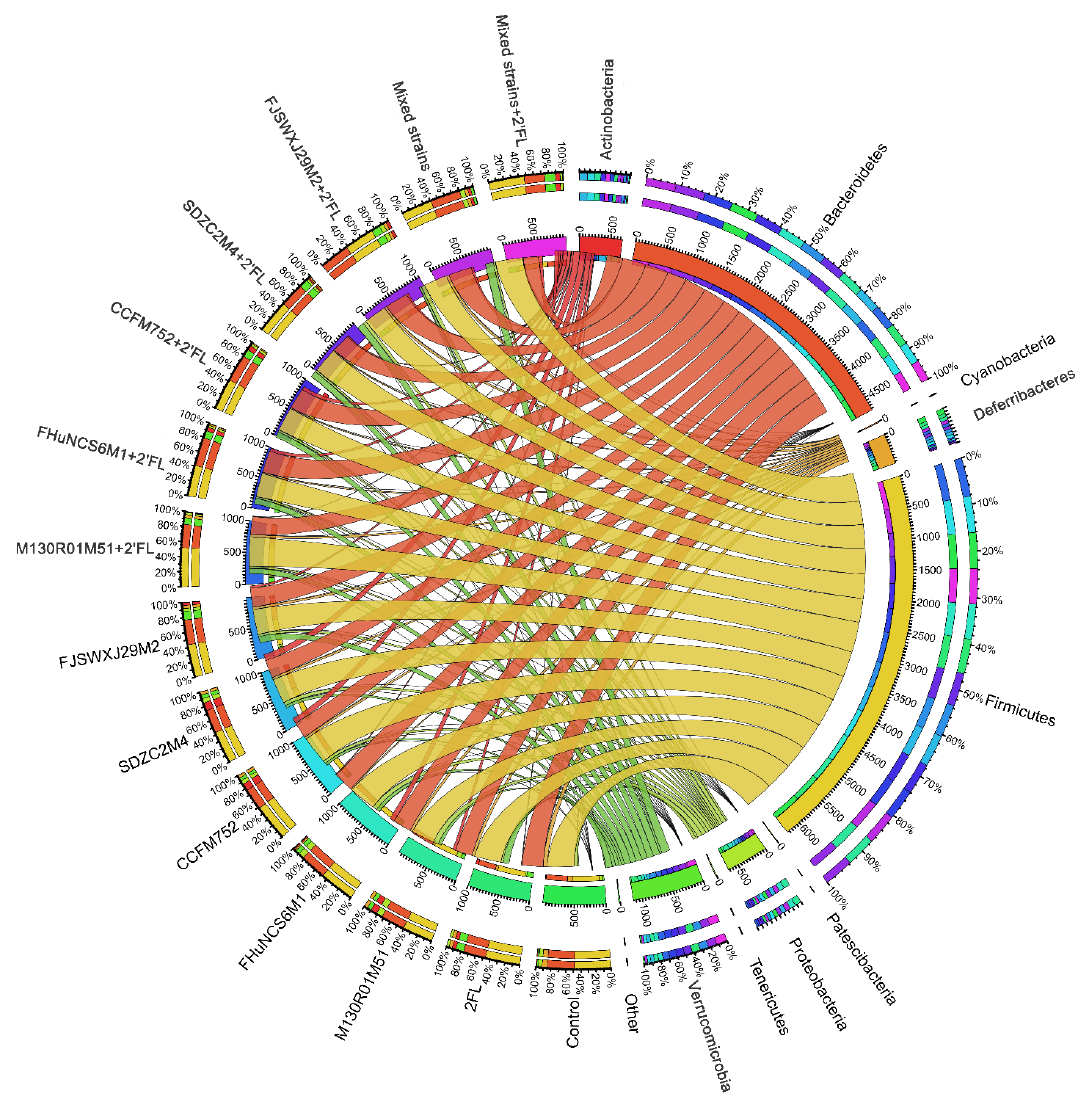
Figure 6. Phylum level composition of Bifidobacterium , Bifidobacterium + 2 (cid:48) FL, mixed strains group, and mixed strains + 2 (cid:48) FL groups (n = 8 for each